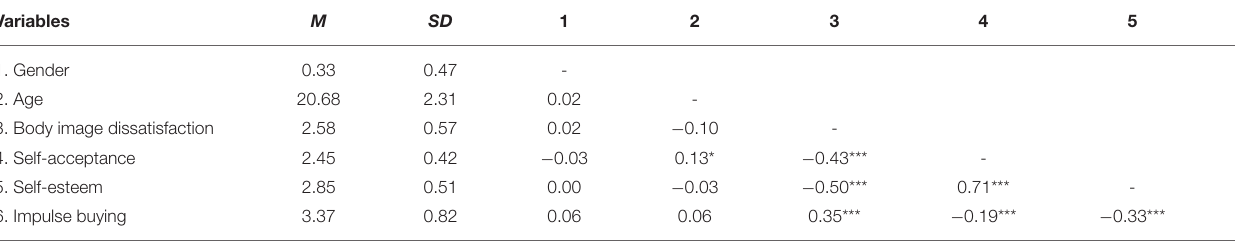
TABLE 1 | Descriptive statistics and correlations between variables.